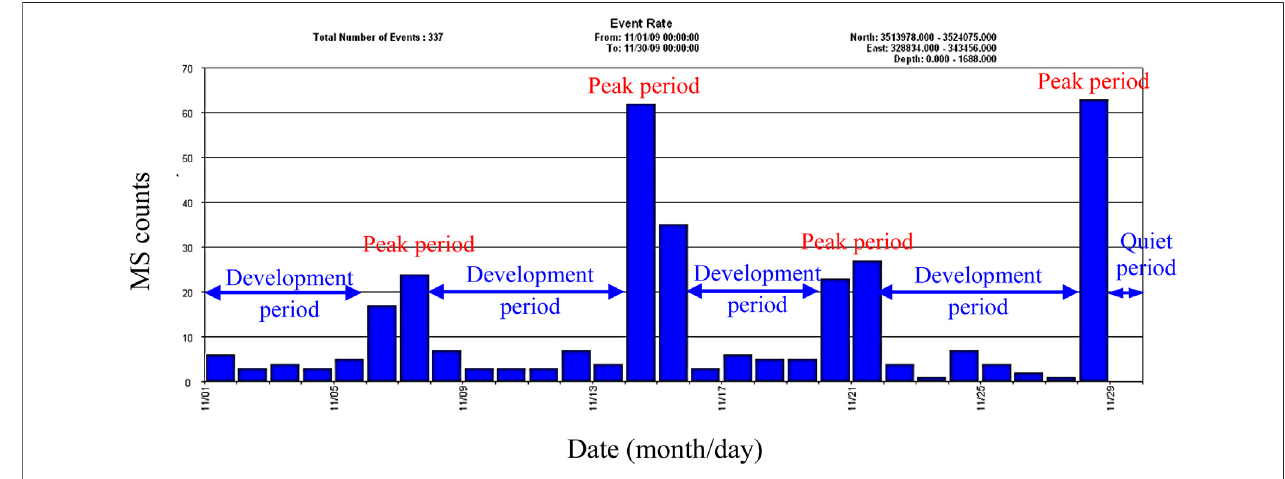
FIGURE 6 | Frequency of microseismic events based 3S